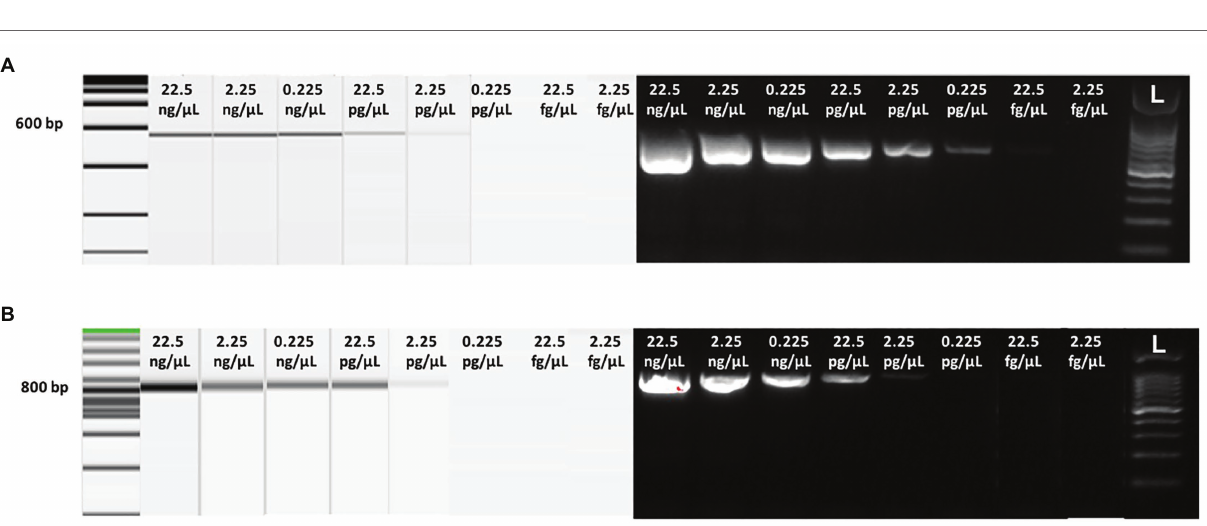
FIGURE 5 | Analytical sensitivity of conventional RT-PCR detected by capillarity and gel electrophoresis using 10-fold serial dilution of purified total RNAs extracted from tomato leaves infected with Sic1/19 isolate of ToBRFV, based on the end-point RT-PCR protocols described by Alkowni et al. (2019; A ) and Ling et al. (2019; B ), respectively. On the top of each lane, total RNA concentration is reported. L = 100 bp ladder